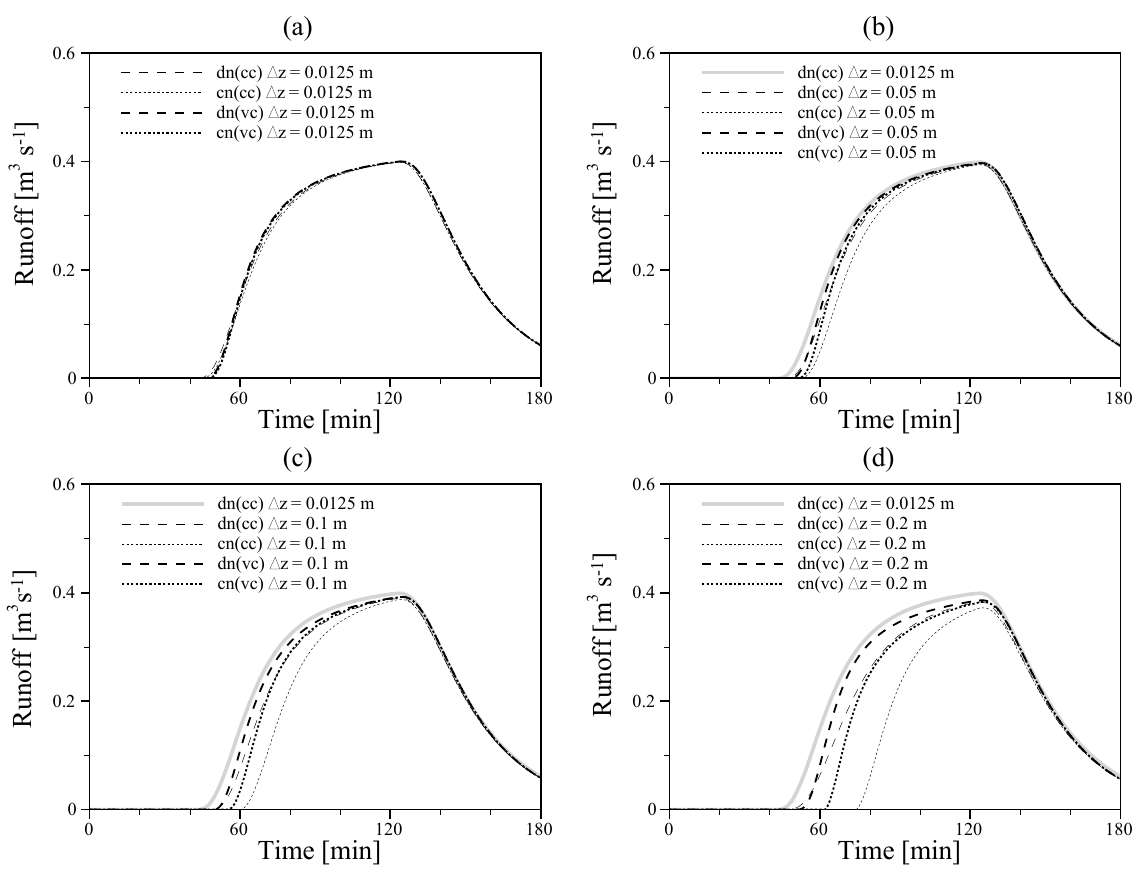
Figure 10. Outflow response for flooding an unsaturated hillslope using different vertical discretizations.